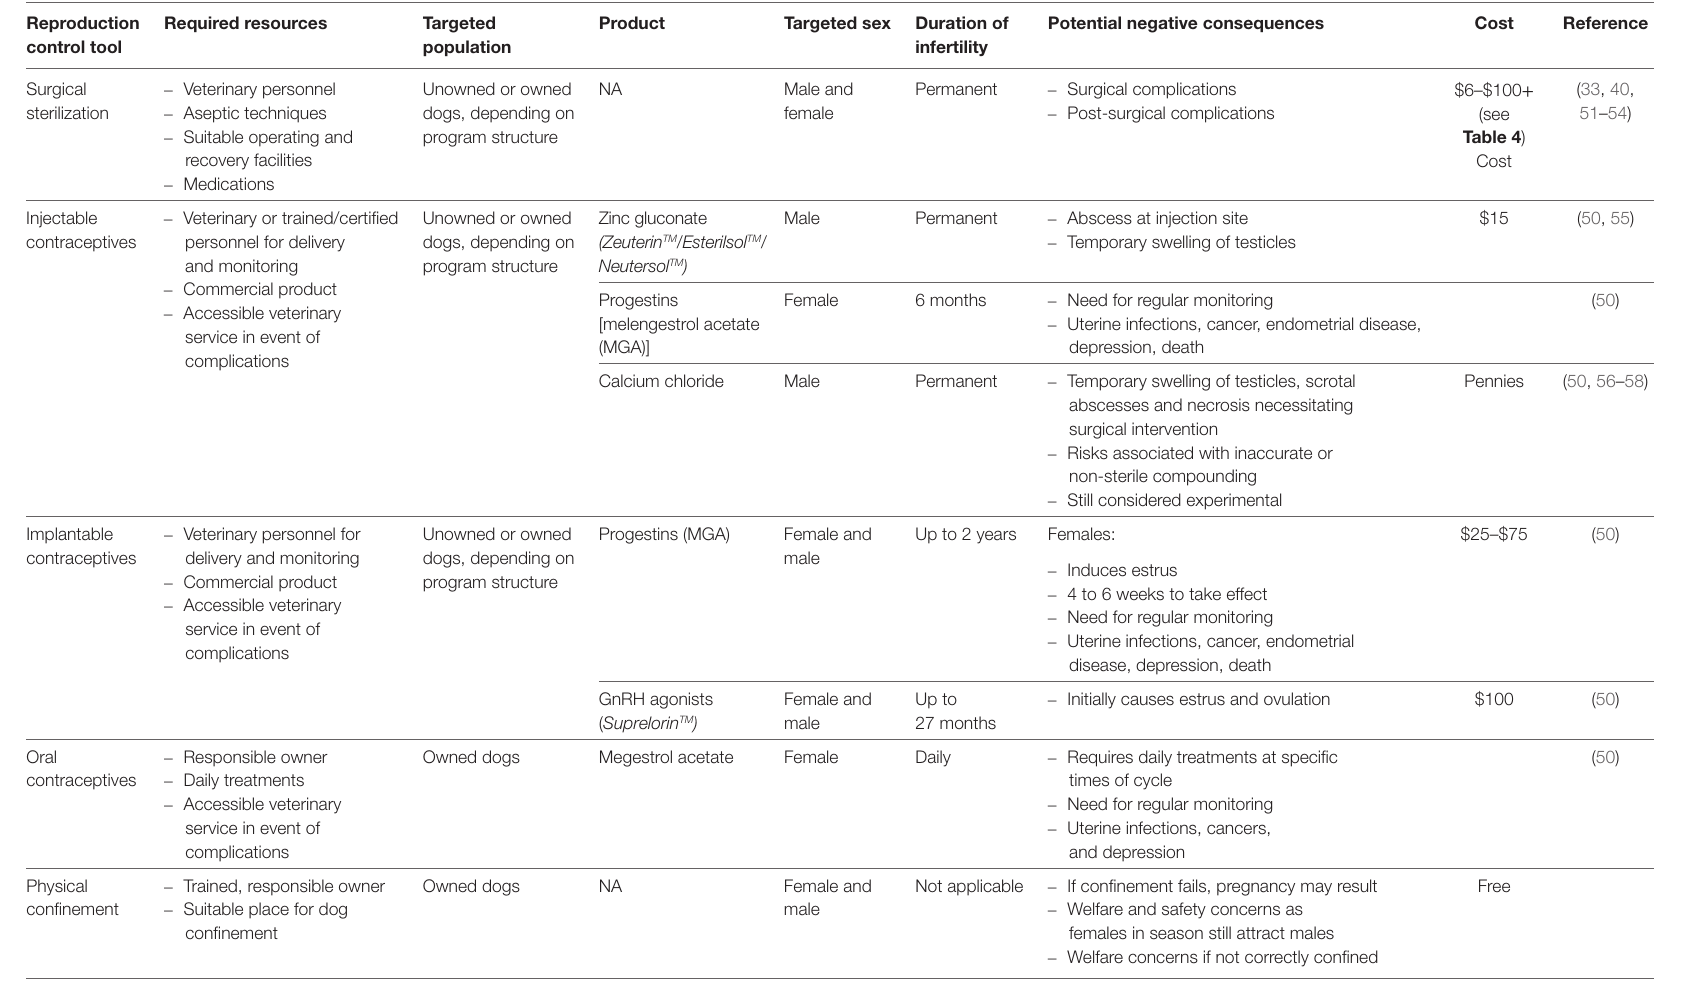
TABLe 1 | Reproductive Control tools currently available that can be incorporated into dog population